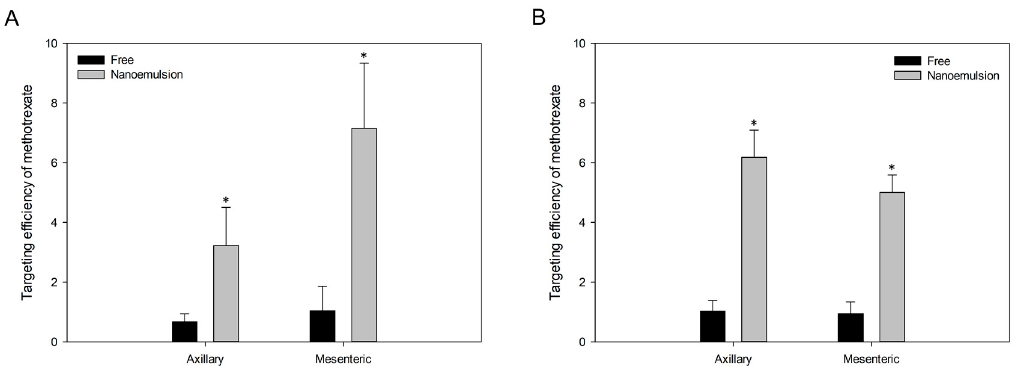
Figure 7. Lymphatic targeting efficiency of methotrexate to axillary and mesenteric lymph nodes at 2.5 h after oral ( A ) or intravenous ( B ) administration of free methotrexate and methotrexate-loaded nanoemulsion to rats. Vertical bars represent standard deviation of the mean ( n = 5). * p < 0.05 compared with free methotrexate.